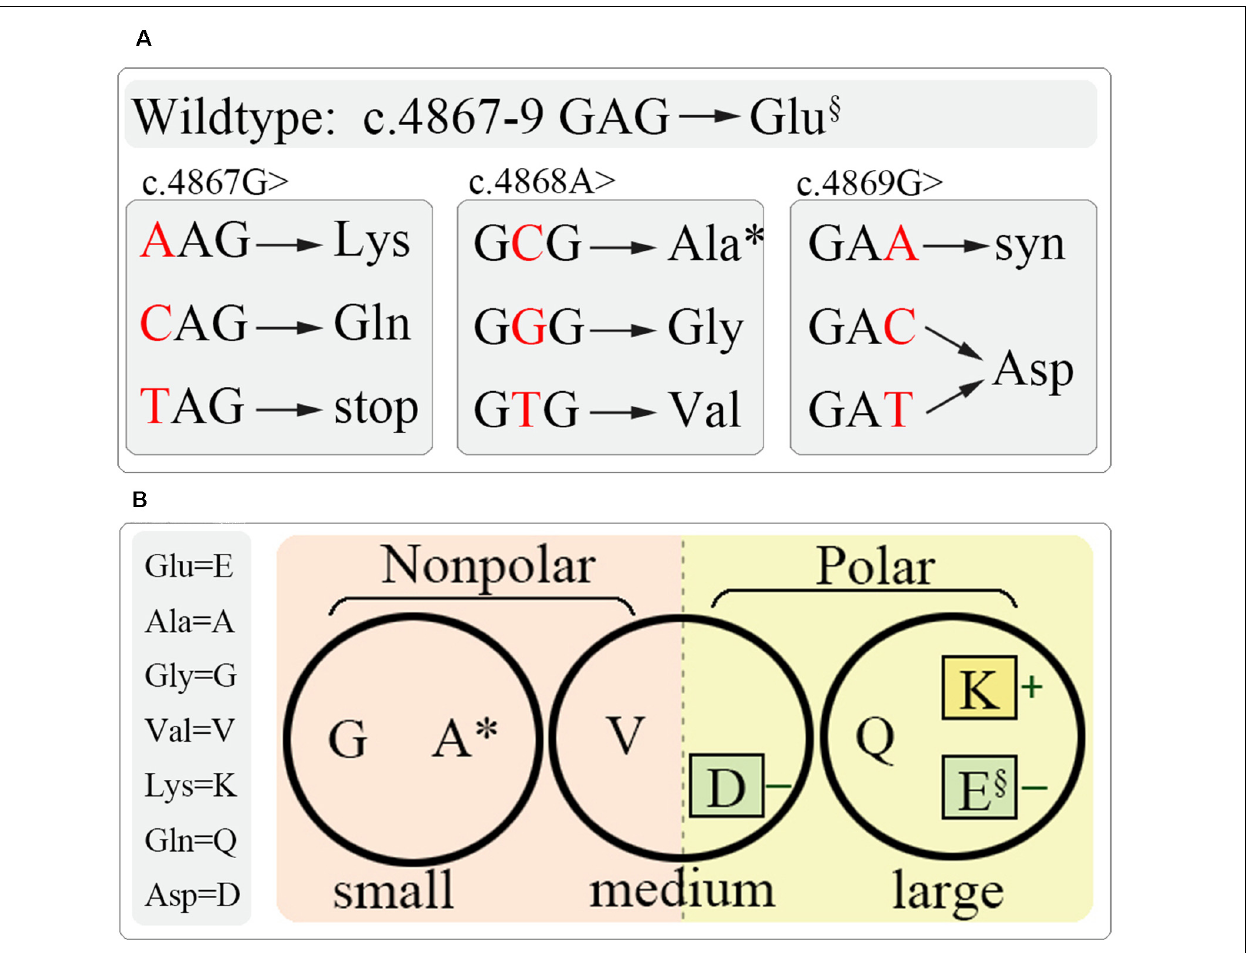
FIGURE 3 | Schematic diagram of site-directed mutagenesis at E1623. (A) All latent variants by single nucleotide variation at c.4867–4869. (B) Residue grouping according to their basic physiochemical properties, including molecular weight (circles), polar (colored squares), and charge (little colored squares). §, wild-type; ∗ , the identified